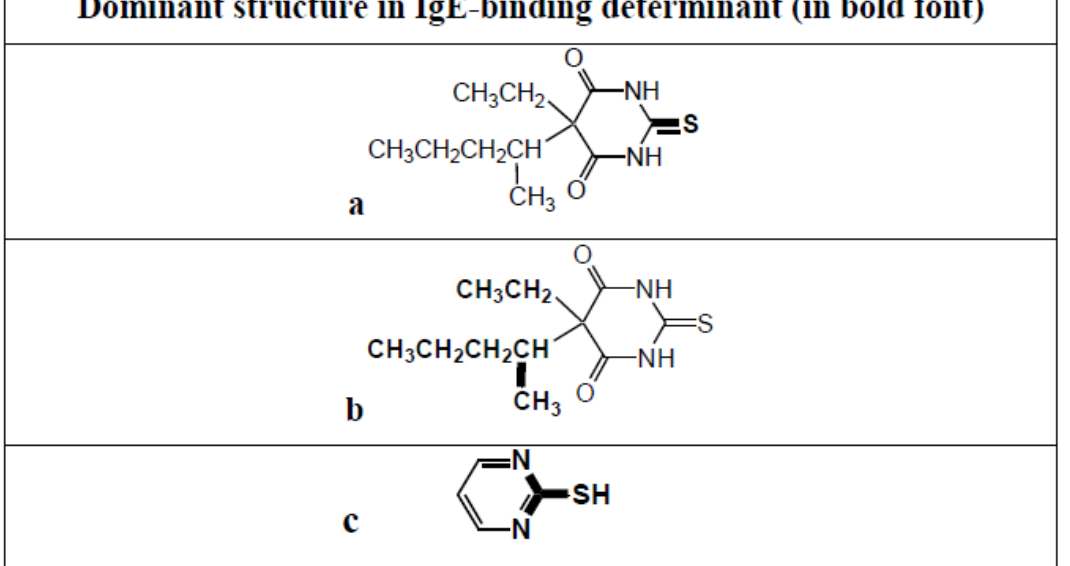
Figure 18. Thiopentone allergenic (IgE antibody-binding) determinants identified using quantitative hapten inhibition studies together with sera from patients who experienced anaphylaxis to the induction agent. Determinants (shown in bold) are the regions of the pyrimidine ring encompassing the attached sulfur atom ( a ) and the ethyl and secondary pentyl groups at position 5 of the ring ( b ). 2-Mercaptopyrimidine ( c ), unlike thiopentone, inhibits binding of IgE in sera from patients allergic to NMBDs to the ‘thiopentone’ solid